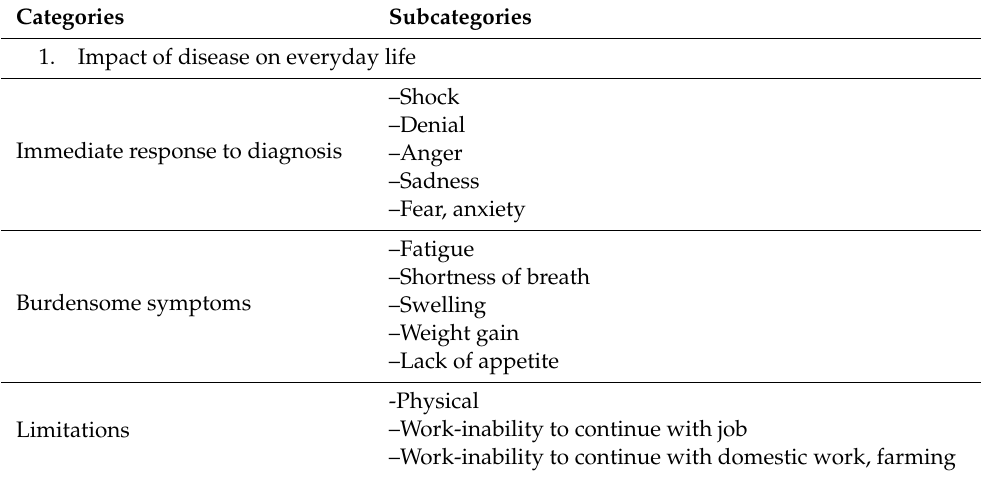
Table A1. Categories and subcategories generated by qualitative content